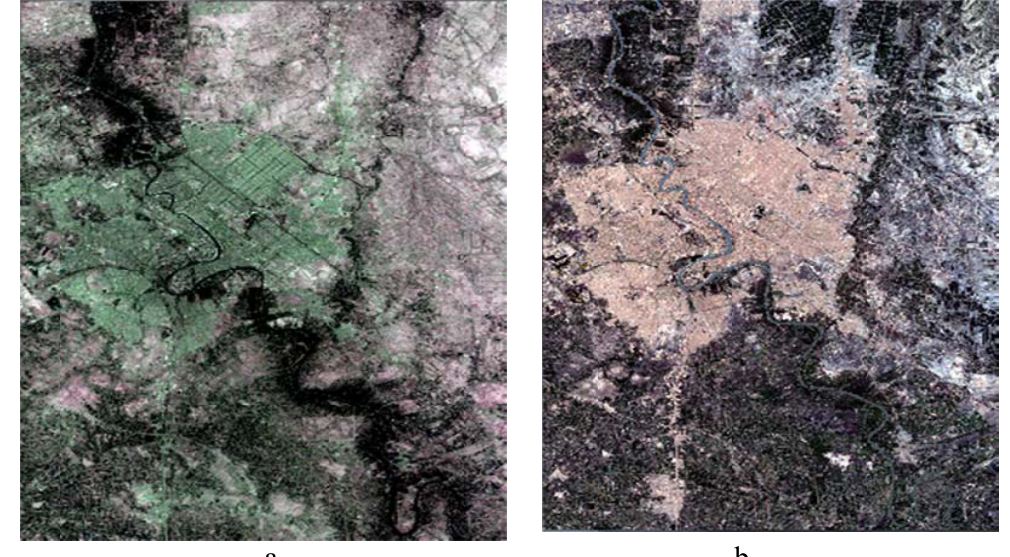
captured by lansat-7 tatistical pro Waveleng (µm)